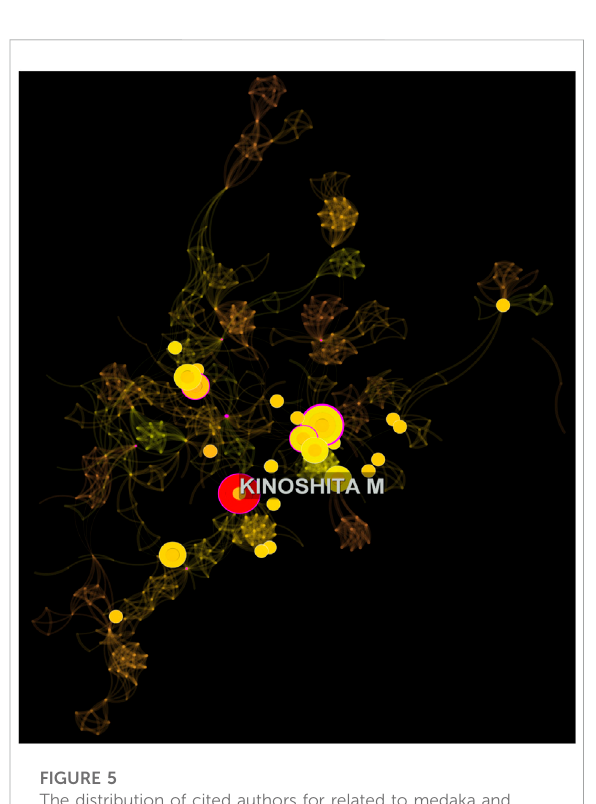
FIGURE 5 The distribution of cited authors for related to medaka and climate change.